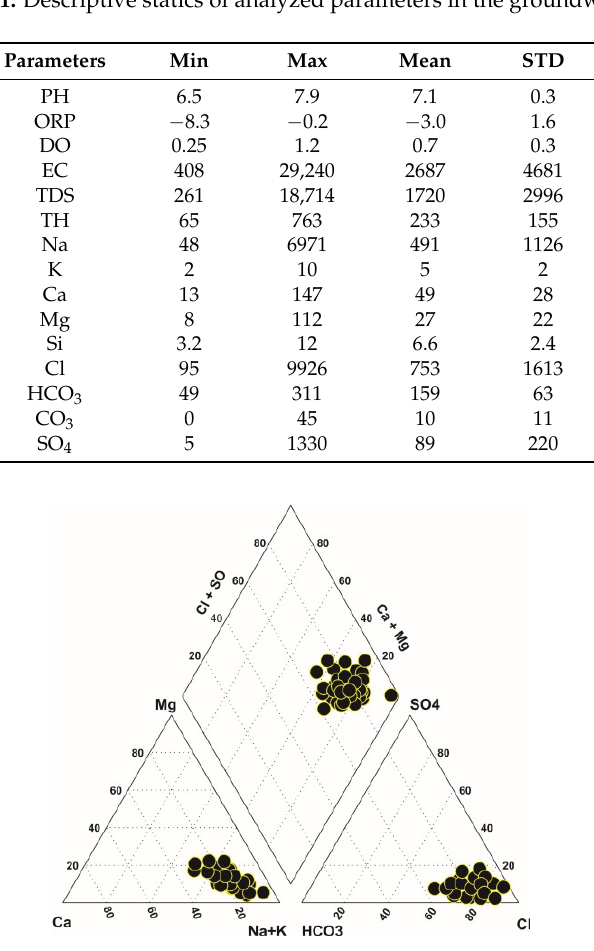
Table 1. Descriptive statics of analyzed parameters in the groundwater.